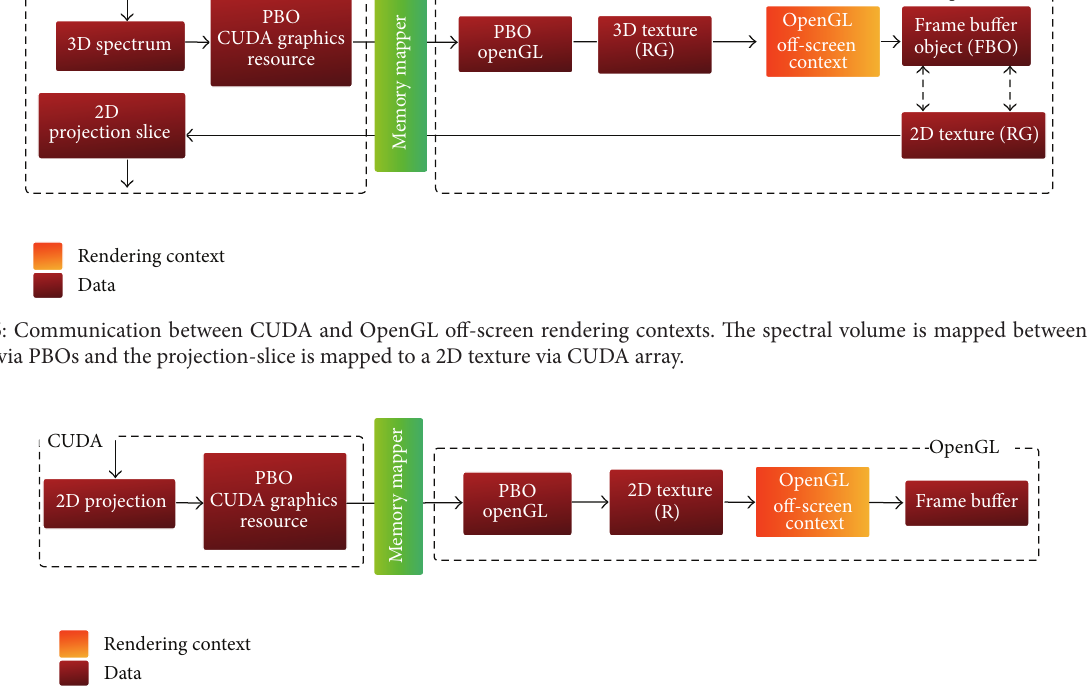
Figure 7: Communication between CUDA and OpenGL on-screen rendering context. The final projection is mapped between the two contexts via the